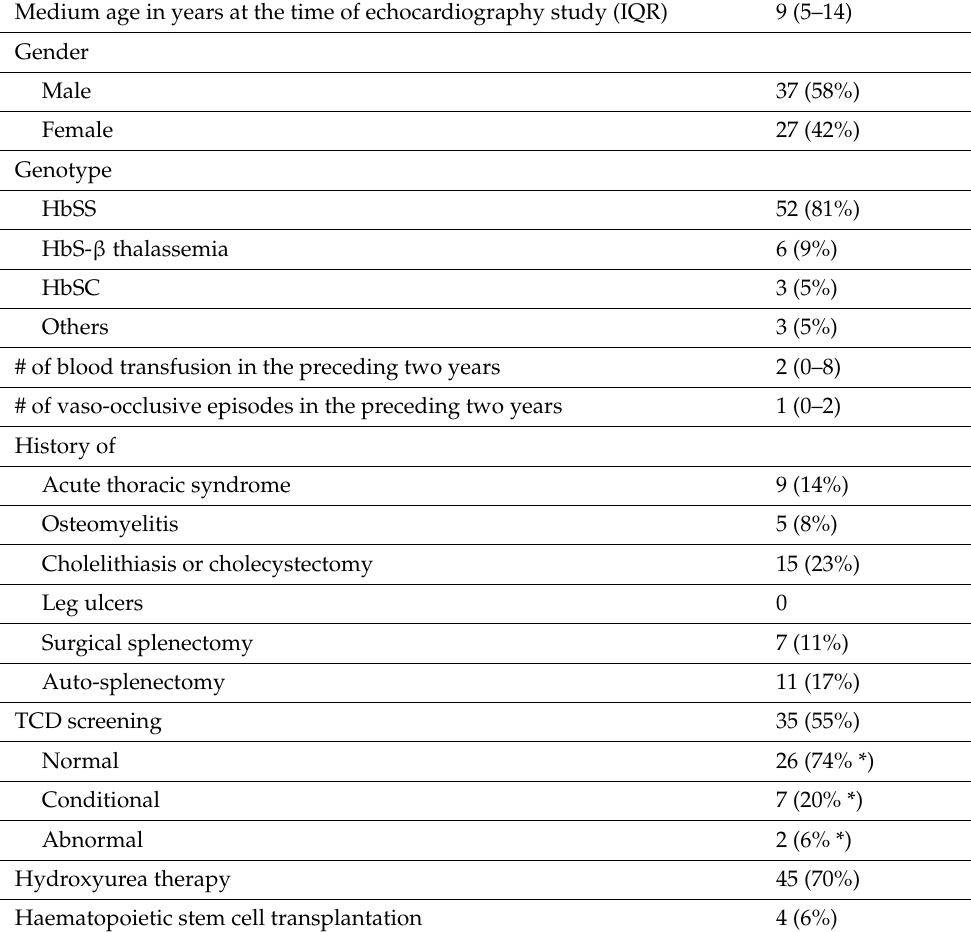
Table 1. Clinical characteristics of the cohort ( n =